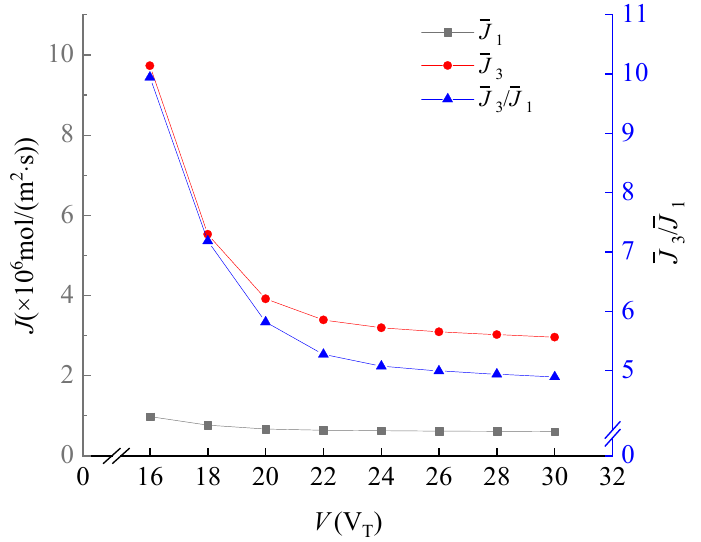
Figure 5. The dependence of the average flux of Li + , the average flux of Mg 2+ and the Mg 2+ /Li + flux ratio on V . Values of other parameters are: V = 30V T , u out = 1 mm/s, u 1 = 0.63 mm/s, u 2 =1 mm/s, 18 µ m ≤ y ≤ 31.5 µ m, x = 96 µ m.